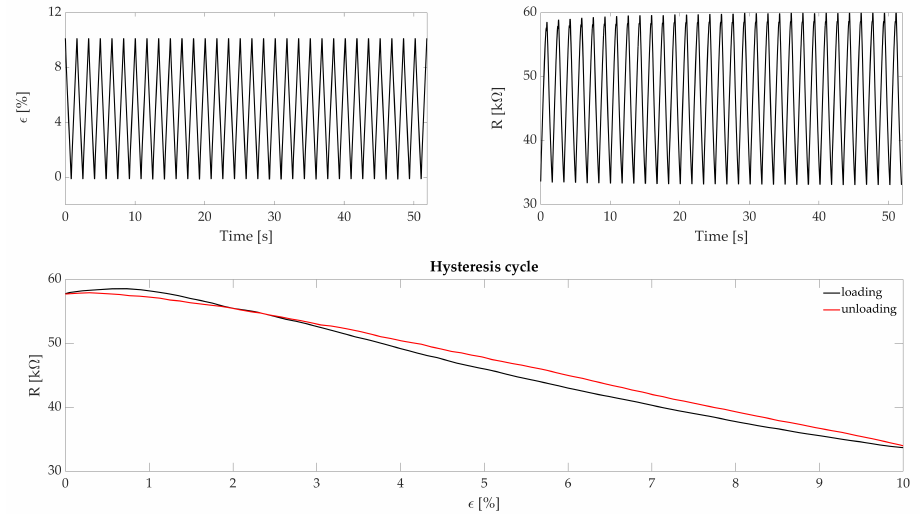
Figure 3. The top image represents the cyclic displacements provided to the sensor by the testing machine and the according ∆ R . The bottom image represents a single hysteresis cycle where the black line represents the loading part and the red line the unloading of the